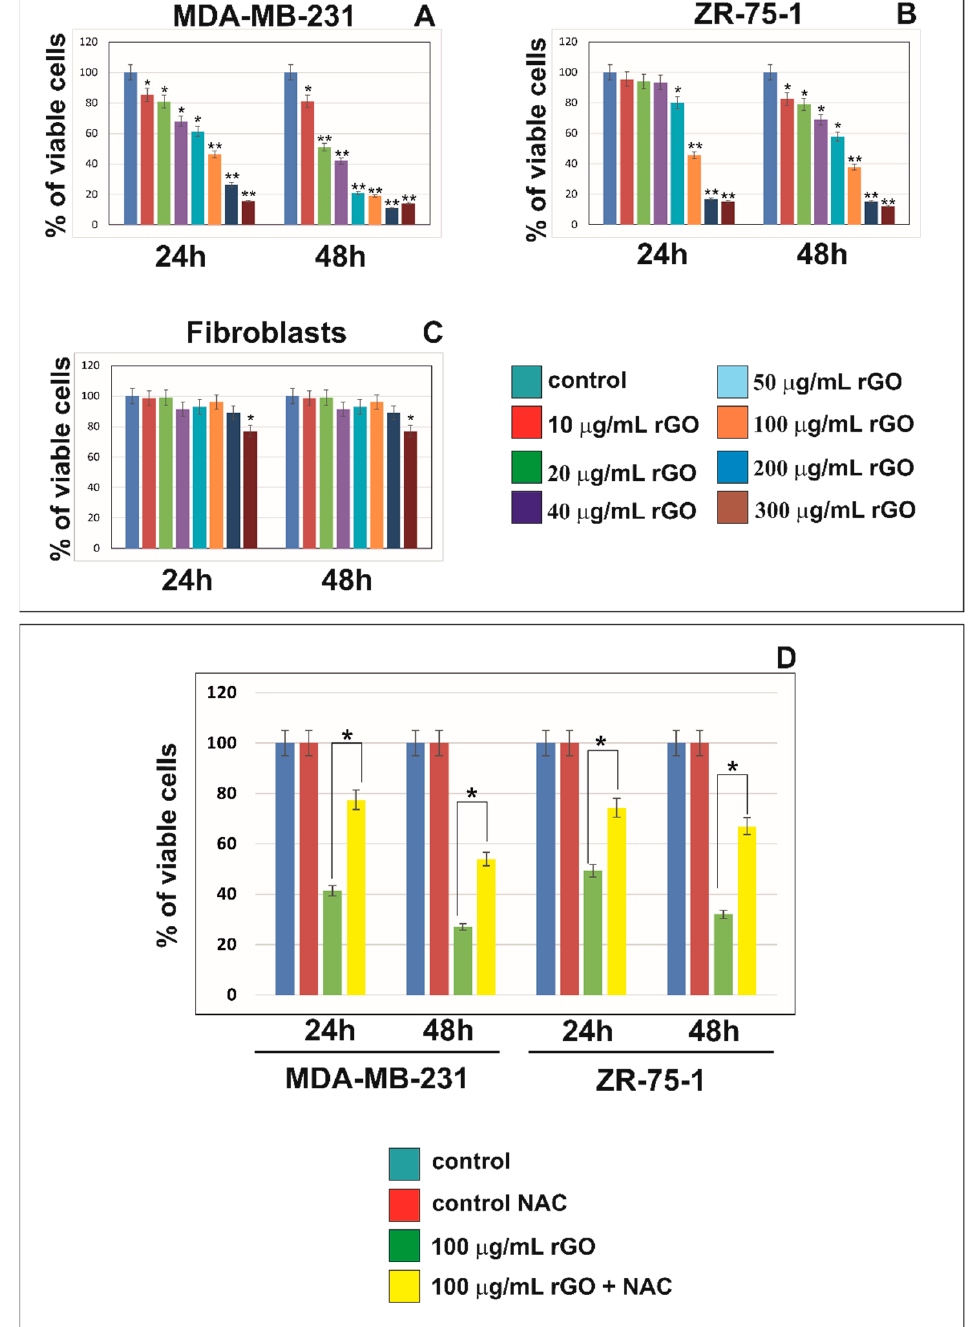
Figure 1. The viability of MDA-MB-231 ( A ), ZR-75-1 ( B ) and human skin fibroblasts ( C ) treated with different concentrations (10 to 300 µ g/mL) of rGO for 24 and 48 h. Panel ( D ) presents the viability of MDA-MB-231 and ZR-75-1 cells treated with 100 μ g/mL of rGO or 100 μ g/mL of rGO + NAC (5 mmol/L), in comparison to the control cells, for 24 and 48 h. Mean values from three independent experiments ± SD are presented. Significant alterations are expressed relative to controls and marked with asterisks. * p < 0.05 or ** p < 0.001.